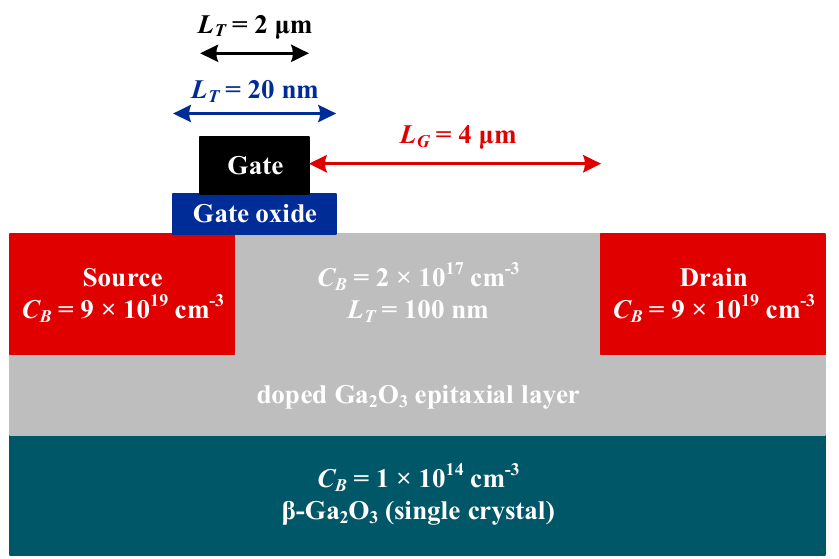
Figure 1. Modelling UWBG semiconductor switches. Table 1. Parameters used in TCAD for analyzing conduction behavior of Ga 2 O 3 switches.